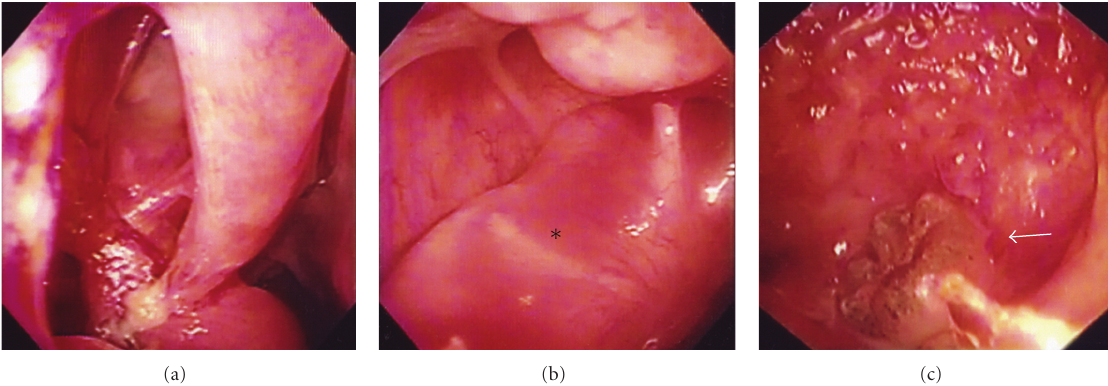
Figure 3: (a) Postoperatively, maxillary sinus is visualized through the middle meatus using a flexible fiberscope. (b) Cystic lesion (asterisk) is shrunken in the maxillary sinus. (c) Arrow shows an impacted tooth inside the cystic lesion.